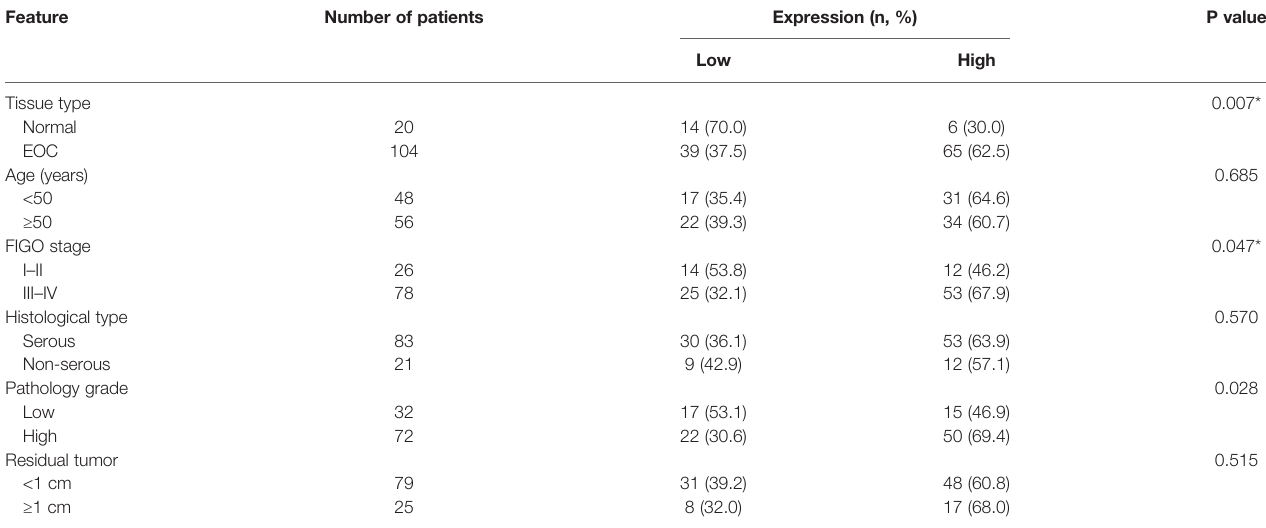
TABLE 2 | Association of EXOSC4 expression levels with features of epithelial ovarian tissue. Feature